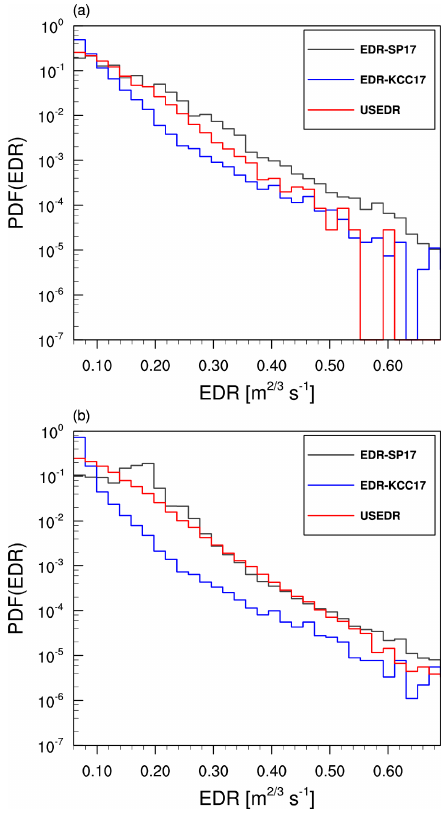
Figure 11. The PDFs of EDR-SP17 (black line), EDR-KCC17 (blue line), and USEDR (red line) at altitudes above 15kft ( ∼ 4 . 57km) from October 2015 to September 2018 over (a) Europe and (b) the Pacific Ocean routes indicated in Fig.